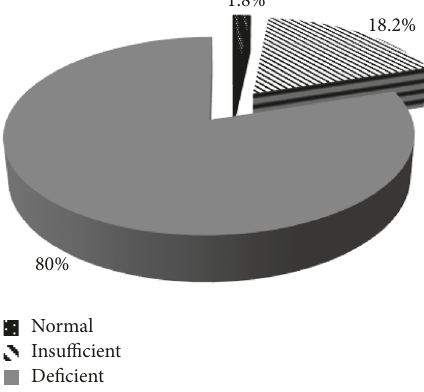
Figure 1: Vitamin D levels in the study population.